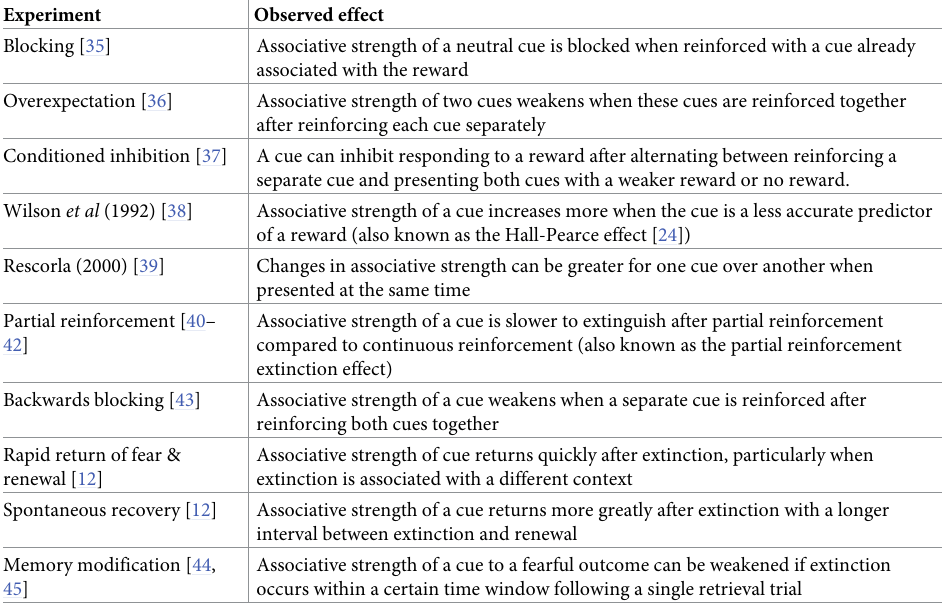
Table 1. Simulated experiments and group-level effect observed in each experiment. Models were evaluated based on its ability to reproduce the observed effect for each simulated